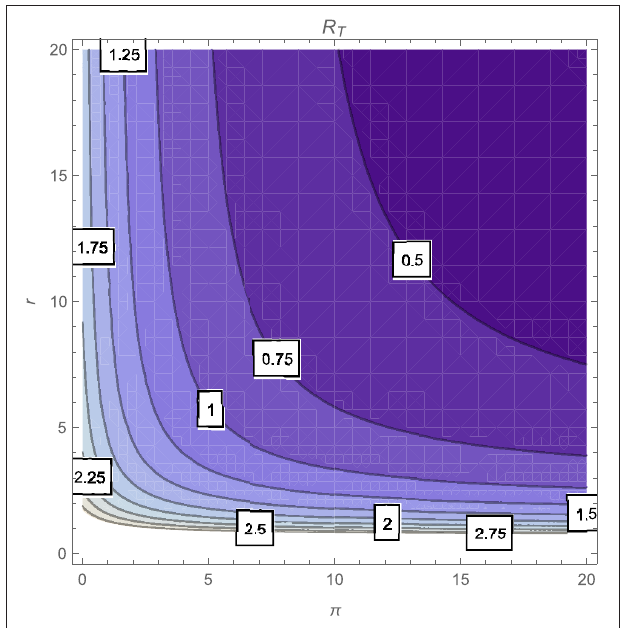
FIGURE 4 | Contour plot of R T as a function of α 1 and α 2